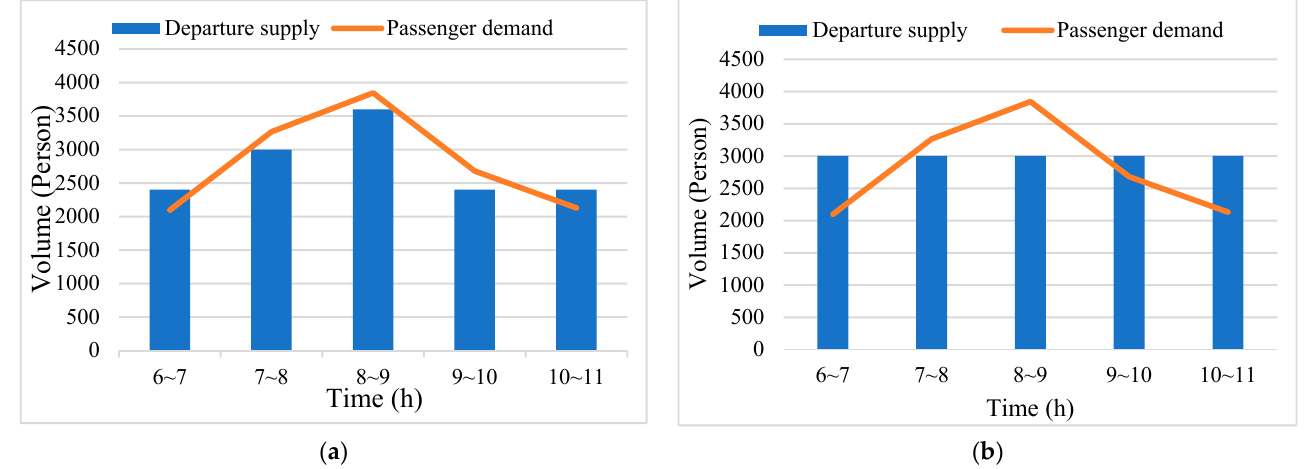
Figure 6. Multi-cycle train timetable and single-cycle train timetable under scenario 2. ( a ) Multi- cycle train timetable. ( b ) Single-cycle train timetable. Red, green, blue, orange, violet, navy blue and purple represents Line 1, 2, 3, 4, 5, 7 and 10 in Table 3, respectively.